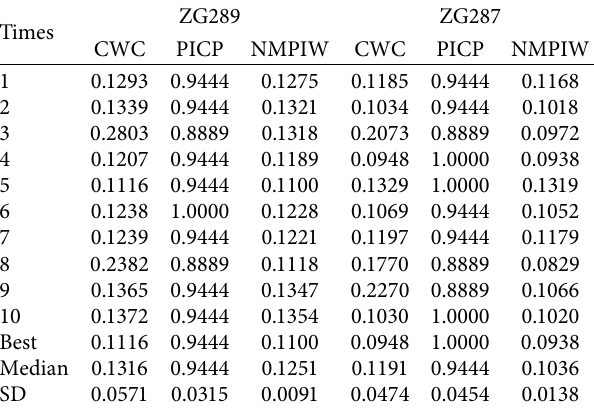
Table 1: Prediction results of the proposed method in the testing set of the Baishuihe landslide. Best means the highest-quality PIs in 10 replicates, and SD means the standard deviation.